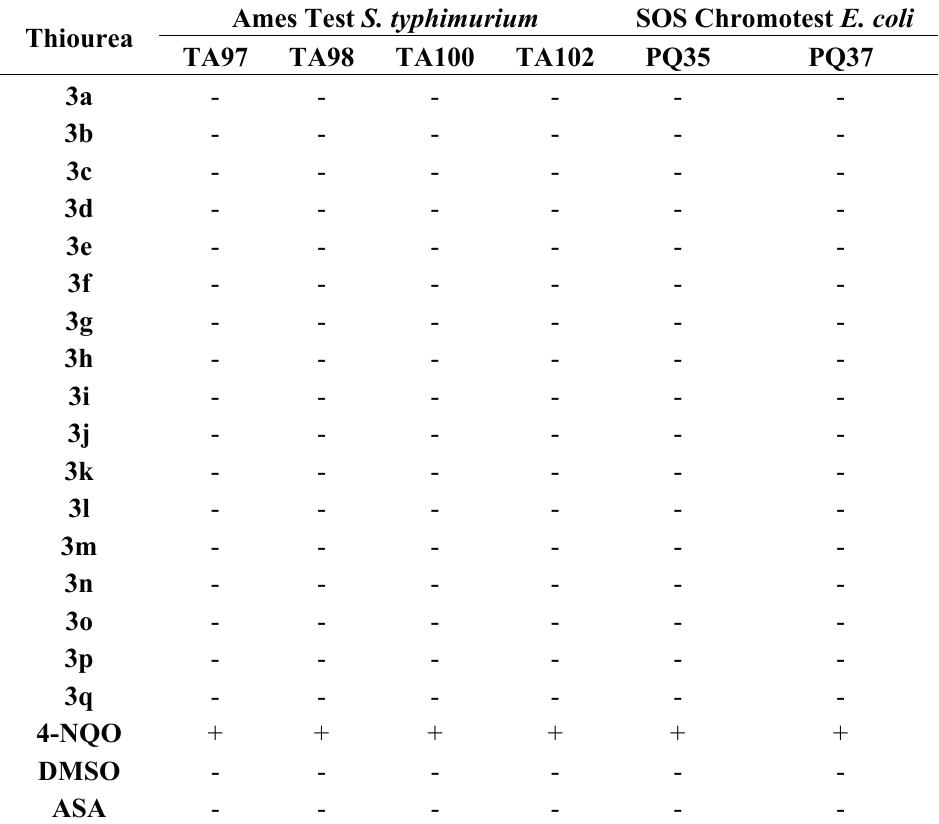
Table 3. Mutagenic and genotoxic activity of thiourea derivatives without metabolic activation evaluated by Ames test and SOS chromotest. The thiourea derivatives were dissolved in dimethylsulfoxide (DMSO) to perform assays. As positive control 4-NQO was used. Results of three different concentrations (10 µM, 100 µM and 500